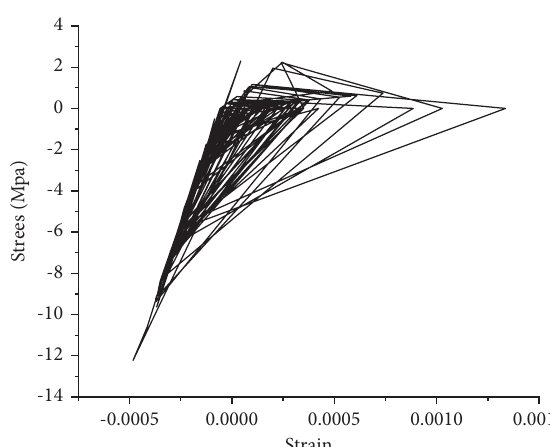
Figure 11: Stress-strain curve of concrete fber at peak value of 0.4g.